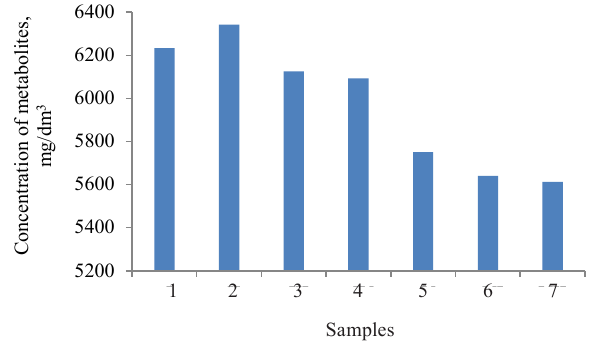
Figure 1 Yeast biomass accumulation (1, 2) and carbohydrate consumption (3, 4) patterns during grain wort fermentation using grain wort treated with phytases (1, 3) and the control sample of phytase-free grain wort (2, 4)